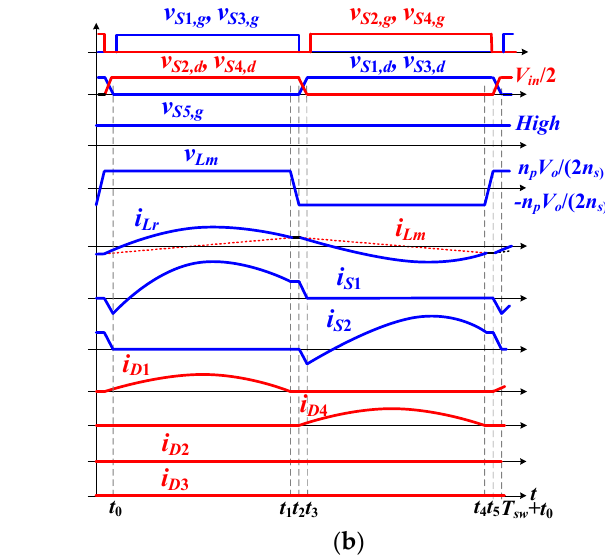
Figure 3. Main PWM signals and circuit waveforms of the presented converter for ( a ) the low output voltage range and ( b ) the high output voltage range.